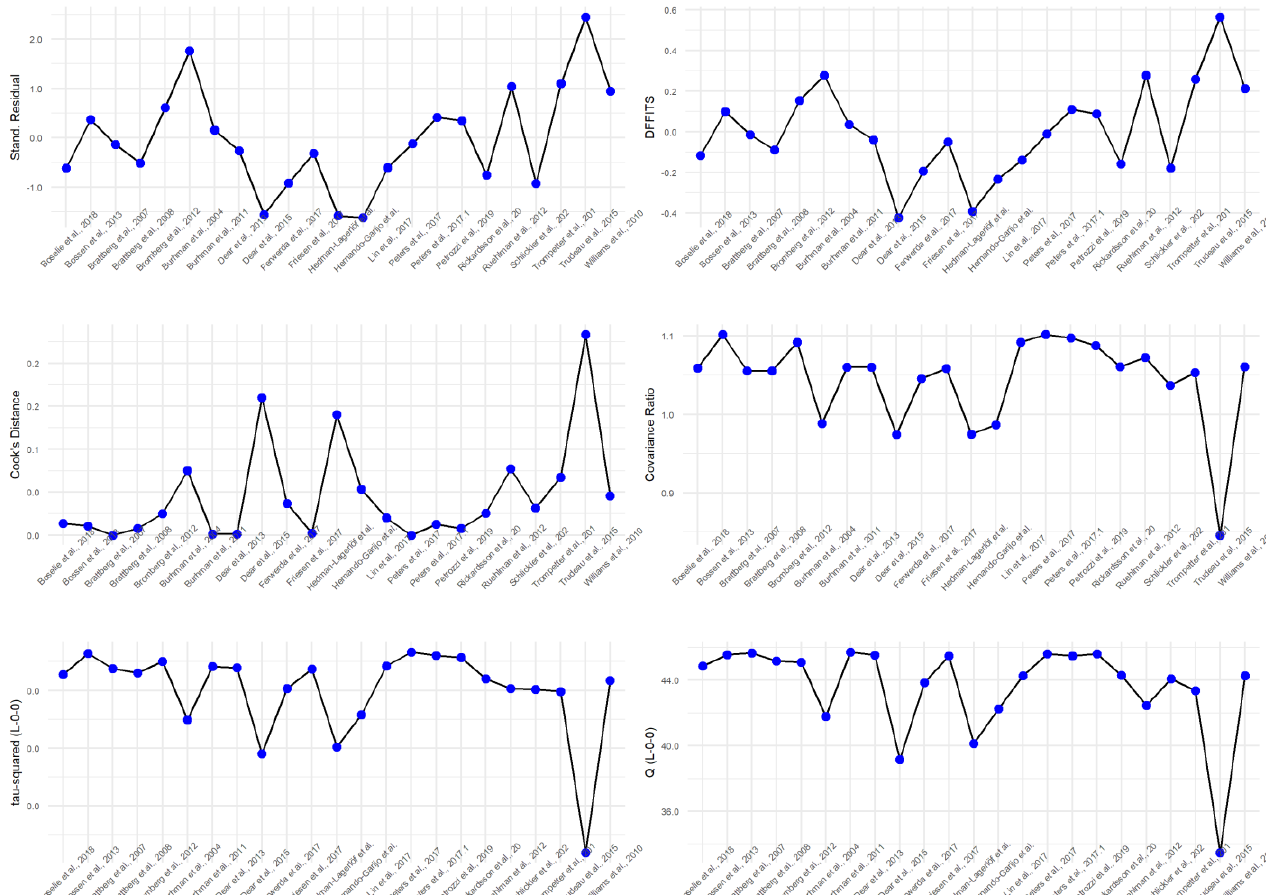
Figure A12. Influence analyses of all the studies.